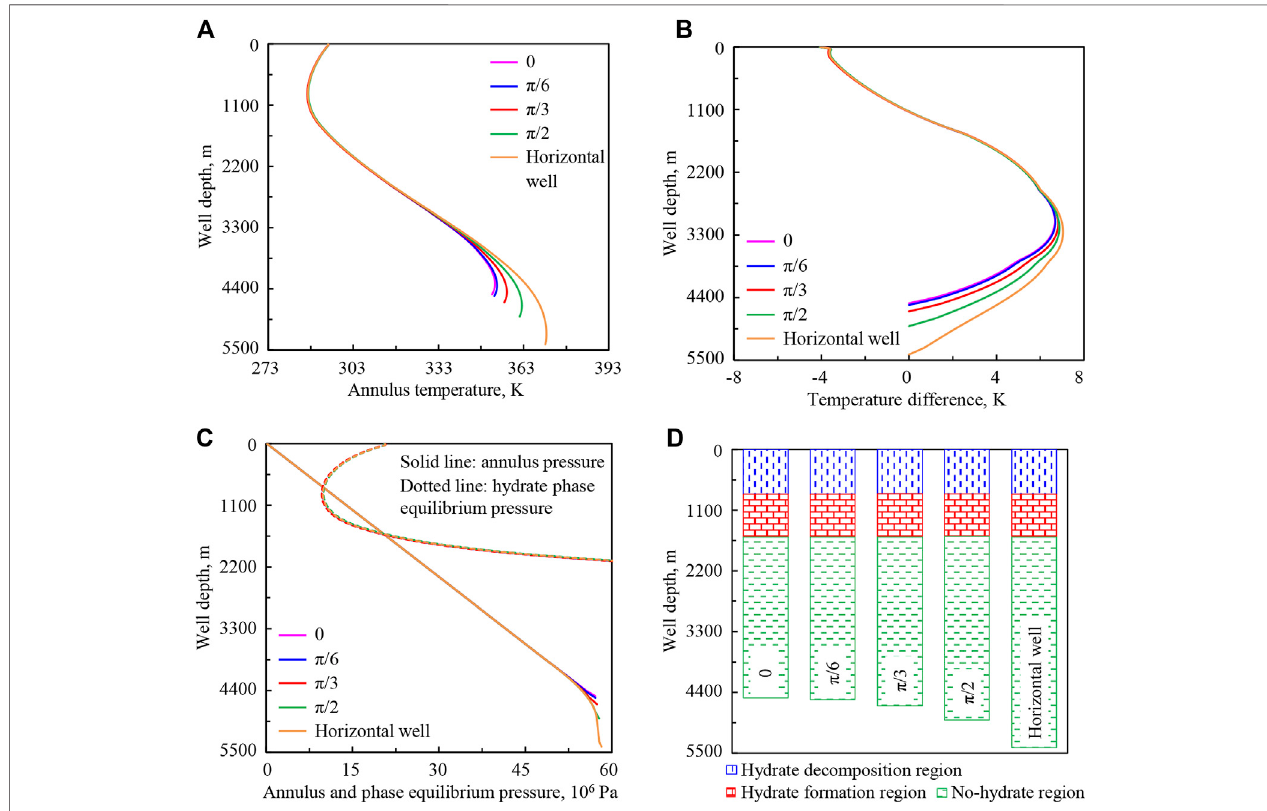
FIGURE 18 | Variation regularities of wellbore temperature fi eld, pressure fi eld, and hydrate formation region in deep-water drilling under different hole deviation angles: (A) annulus temperature, (B) temperature difference between the drilling fl uid in the annulus and in drill string, (C) annulus pressure and phase equilibrium pressure, (D) hydrate formation region. The solid lines under different hole deviation angles in (C) are overlapped in the upper well section.